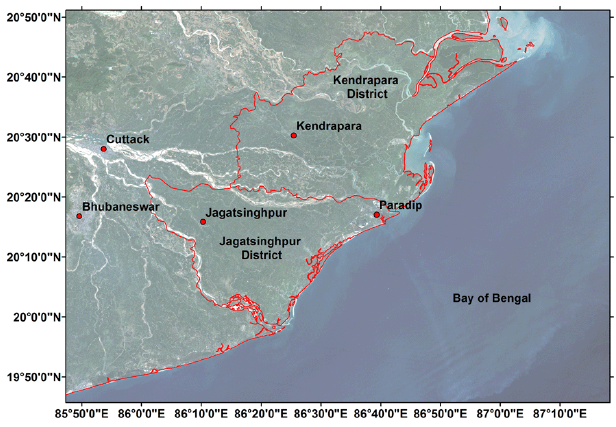
Fig. 1 . Map depicting the location of Jagatsinghpur and Kendrapara districts across the Mahanadi Delta, Odisha, where villages were sampled for household surveys and semistructured interviews. Background imagery is obtained from Landsat TM5 imagery from October